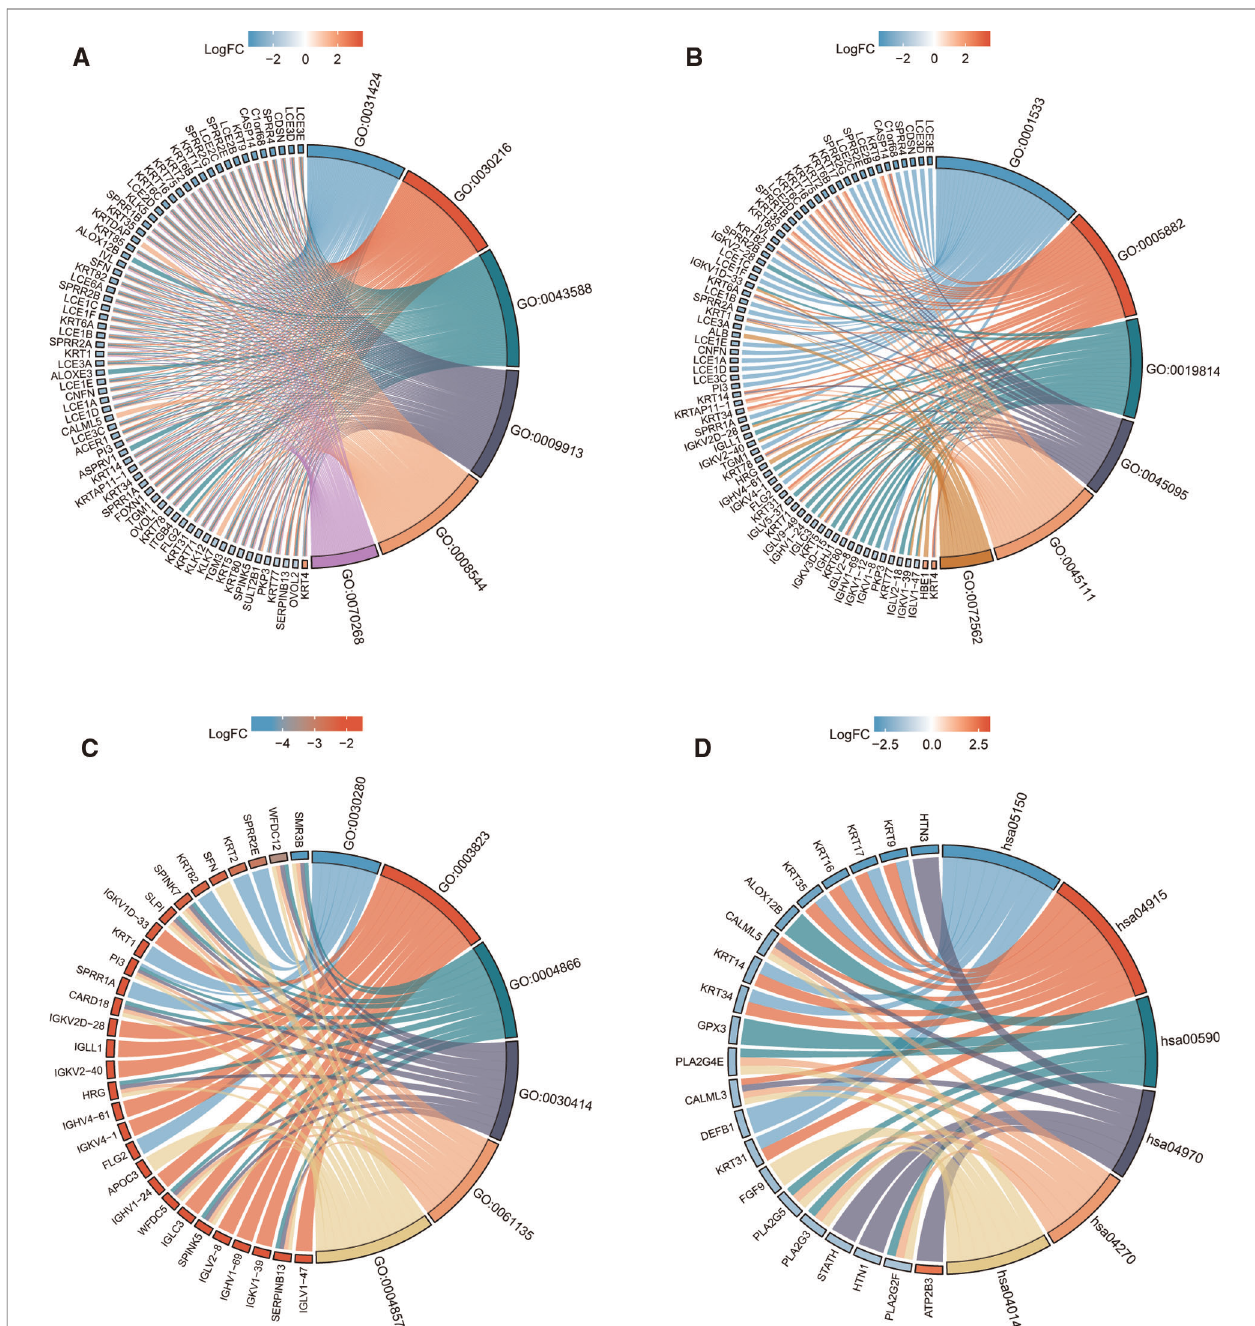
FIGURE 2 | GO/KEGG enrichment analysis of TIM-related DEGs in TCGA-SKCM project. ( A ) Enriched GO terms in the “ BP ” category; ( B ) Enriched GO terms in the “ MF ” category. ( C ) Enriched GO terms in the “ CC ” category; ( D ) KEGG pathway annotations. The right semicircle represents different functional categories, while the left semicircle consists of individual DEGs. Different colors indicate different properties, and the size of the sections represents the number of